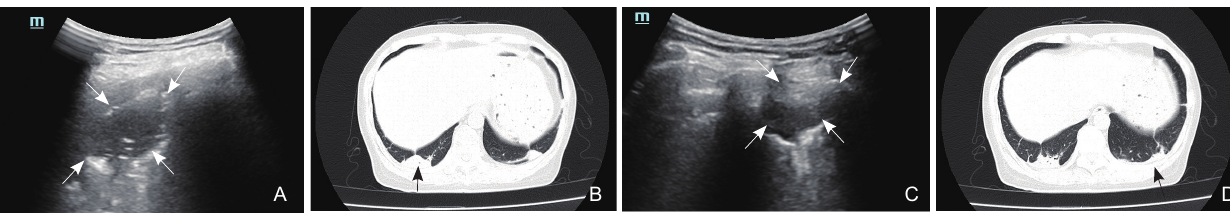
Figure 4 Case 4 of a 65-years-old male. (A and C) Ultrasound observation of lung consolidation (R1, R3) is basically consistent with lung CT results (B and D).